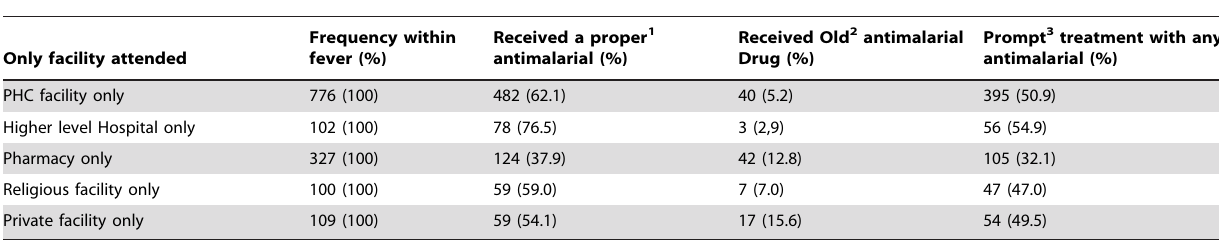
Table 3. Only source of care versus timing and proper antimalarial for fever.